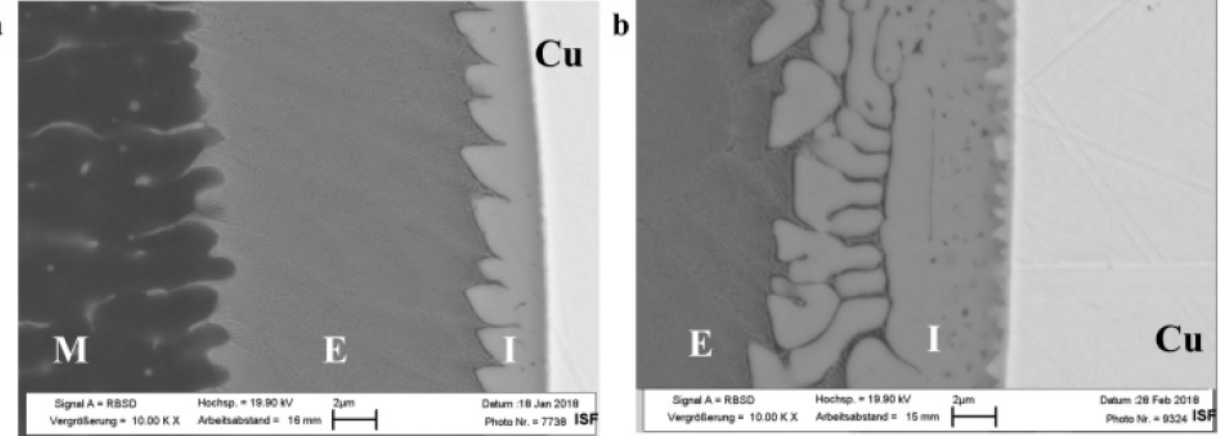
Figure 18. REM analysis (2 µm) of Al–Cu joint: ( a ) ∆x = 200 µm, ( b ) ∆x = 100 µm [68].